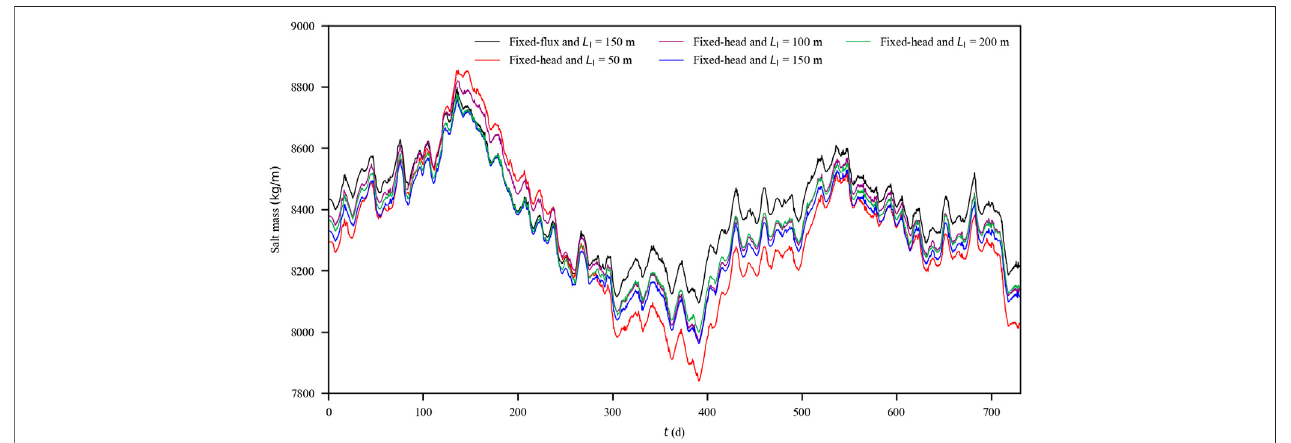
FIGURE 5 | Averaged amount of salt stored in the saltwater wedge every 12.42 h for the cases with fi xed- fl ux ( L I (cid:1) 150 m) and fi xed-head ( L I (cid:1) 50, 100, 150, and 200 m) inland boundaries.